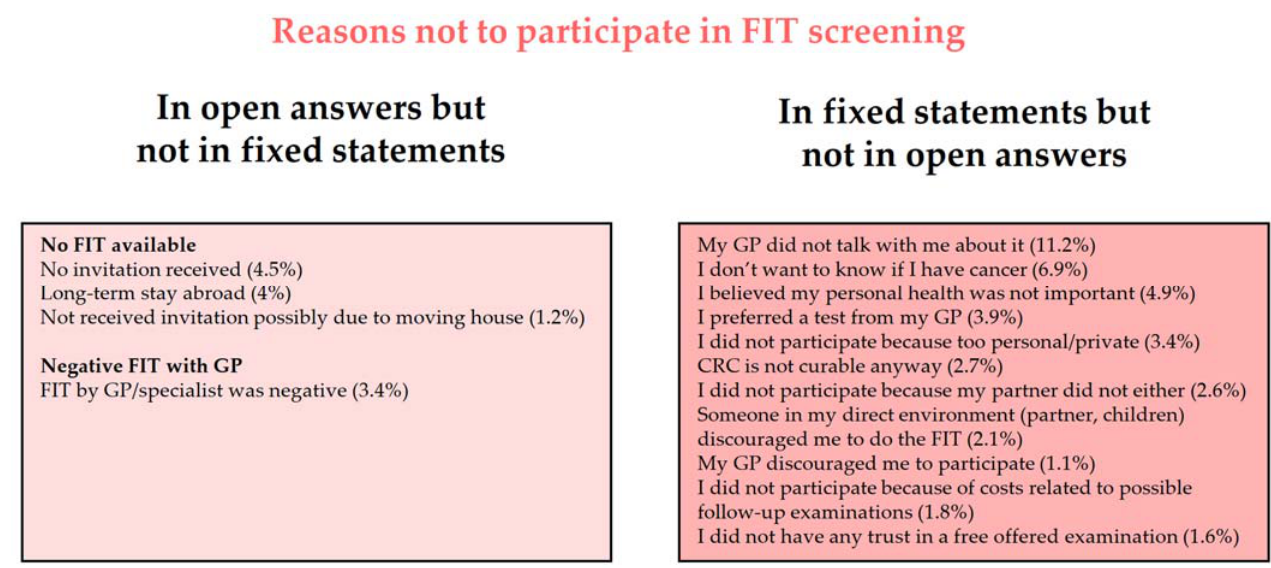
Figure 2. Reasons not to participate in FIT screening among irregular participants in Flanders which are based on either the individuals’ self-reported open answers or given fixed statements (Q1 and S1) but not the other. GP: general practitioner.